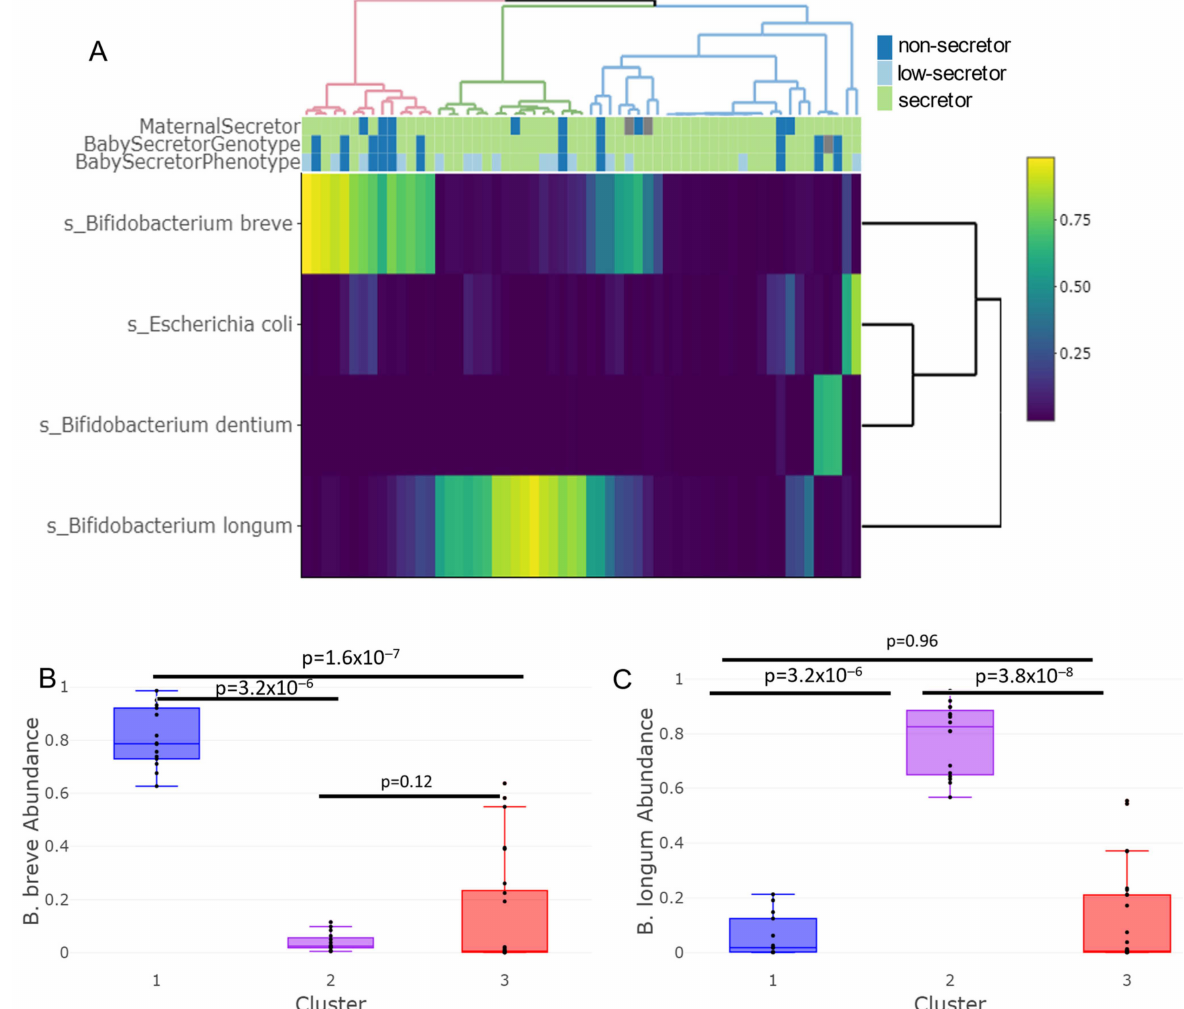
Figure 4. Heatmap of the highest variance in species across all subjects. A high abundance of Bifidobacterium occurred regardless of secretor status, but the species of Bifidobacterium varied. ( A ) By hierarchical clustering, significant clustering occurred in the infant secretor genotype ( p = 0.030) and phenotype ( p = 0.012) but not in the maternal secretor genotype ( p = 0.80). ( B ) The cluster associated with non-secretors was enriched for Bifidobacterium breve by infant genotype and phenotype ( p = 7.9 × 10 − 8 ). ( C ) Bifidobacterium longum was enriched in the cluster primarily associated with the low-secretors ( p = 3.4 × 10 − 8 ). Additionally, there were some subjects that demonstrated a microbiota not dominated by these two species of Bifidobacteria that were primarily associated with the full-secretor